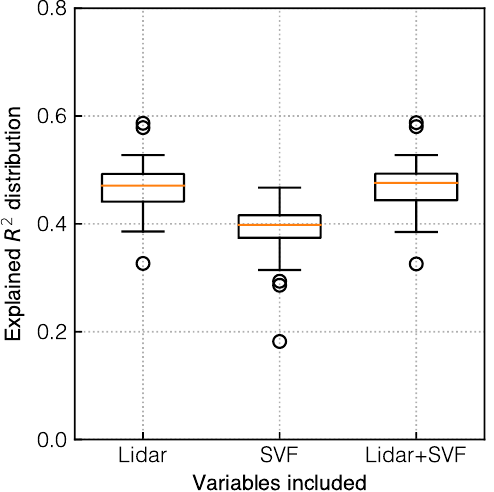
Figure 7. R 2 distribution of the trained Elastic Net model over Wolverton that calculated by predicting the total precipitation using the lidar-derived canopy variables, sky-view factors that were derived from canonical-view photos, and both types of